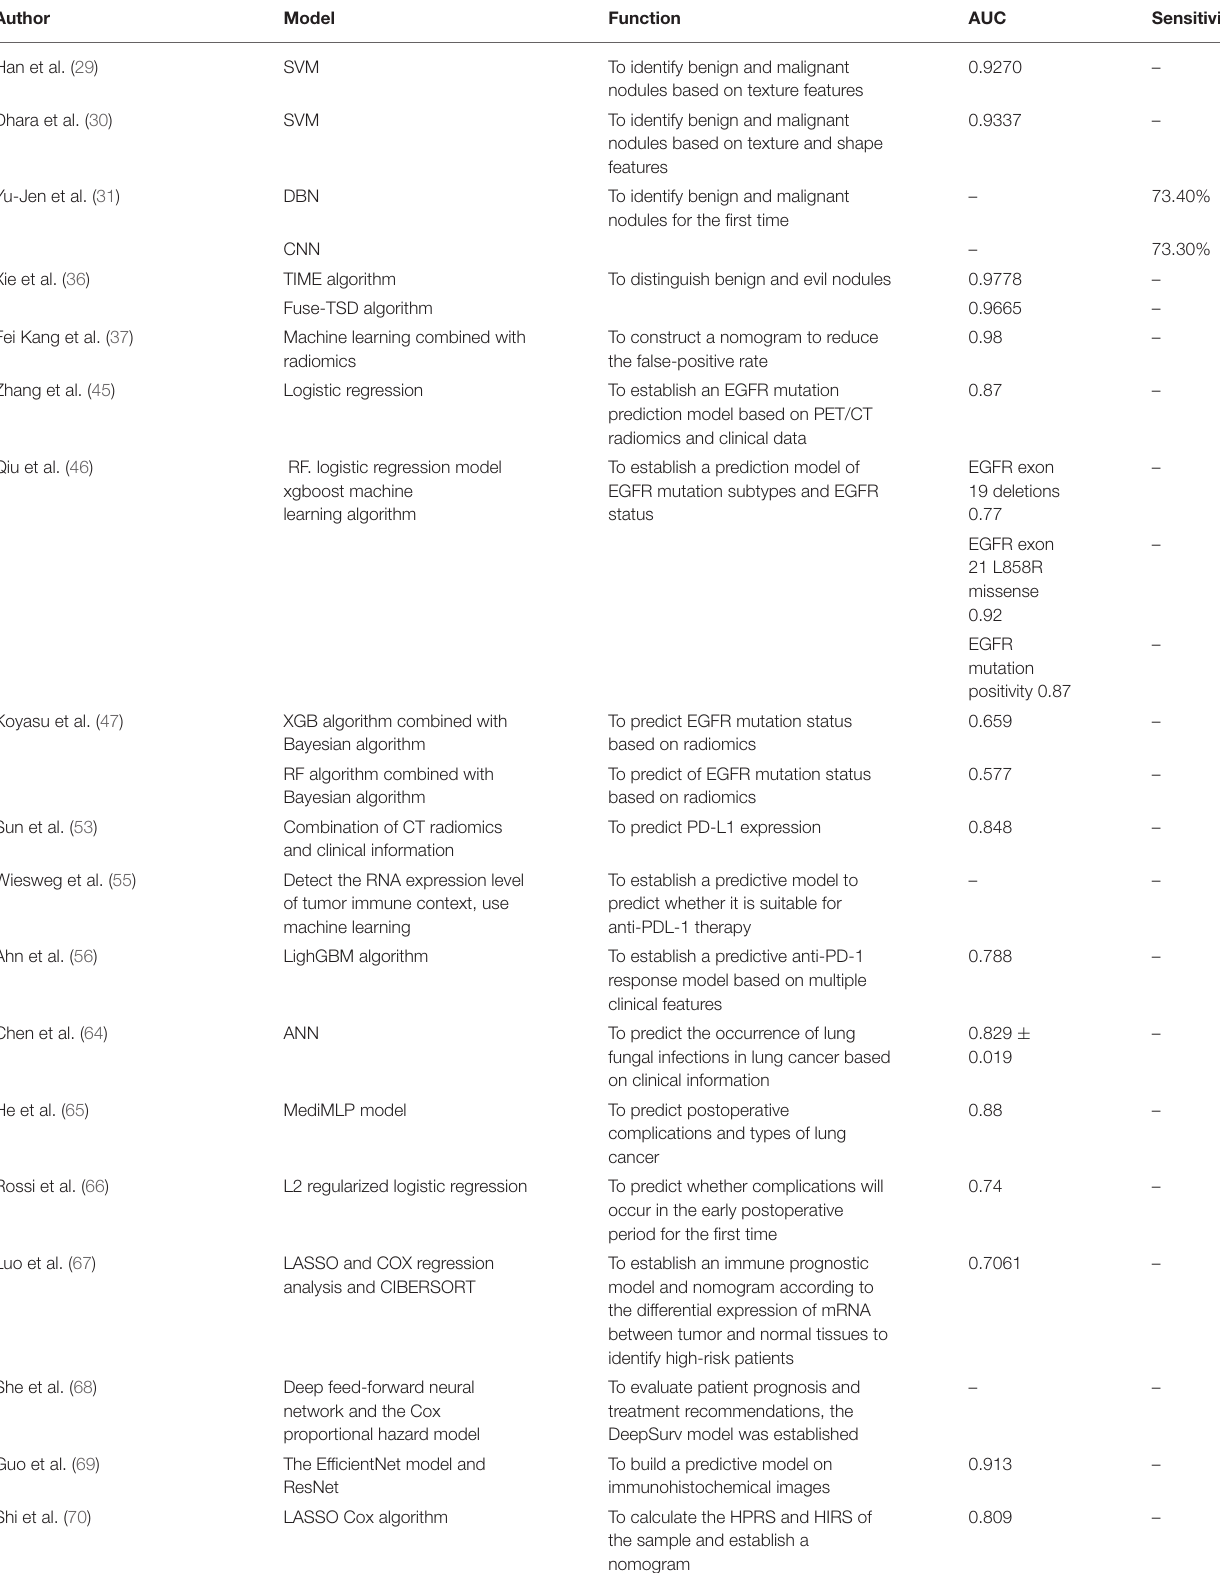
TABLE 1 | The development of AI in the field of lung